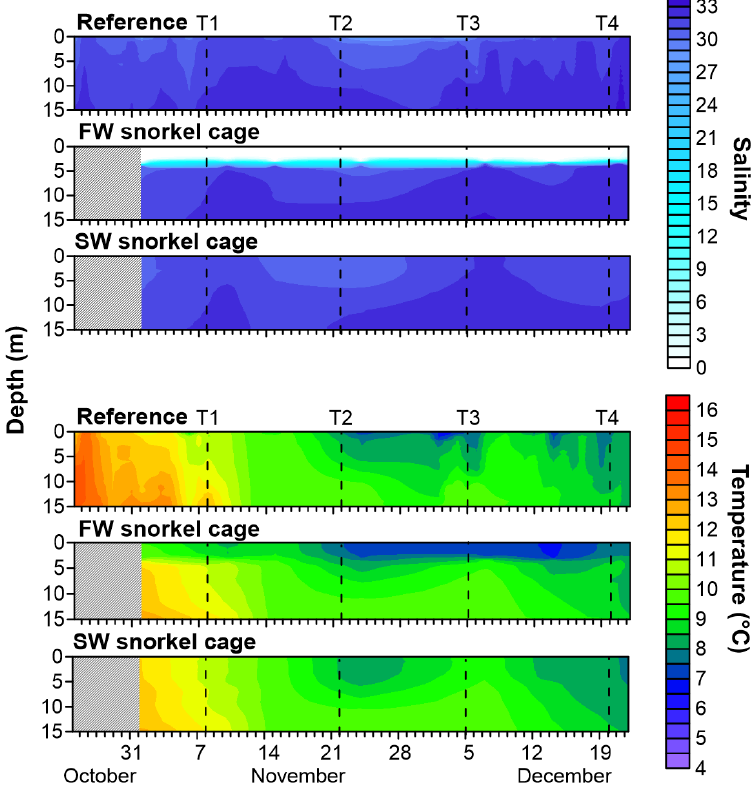
Fig. 1. Depth profiles over time of salinity (top) and temperature (bottom) in a study of the effects of surface environment modification on parasites in farmed Atlantic salmon Salmo salar in southwest Norway. Profiles were measured daily by an automatic profiling CTD buoy at a reference loca- tion, indicative of standard cage conditions and weekly using a CTD in snorkel cages filled with seawater (SW snorkel) or freshwater (FW snorkel). Measurements at the reference location were taken from 24 Oc- tober 2016. Measurements in snorkel cages started on 1 November once freshwater layers were established, and the preceding period is shown as grey shading. Values are from a single FW and a single SW snorkel cage, with similar conditions observed in replicate cages. The 4 sampling times (T1 to T4) are shown by dashed vertical lines